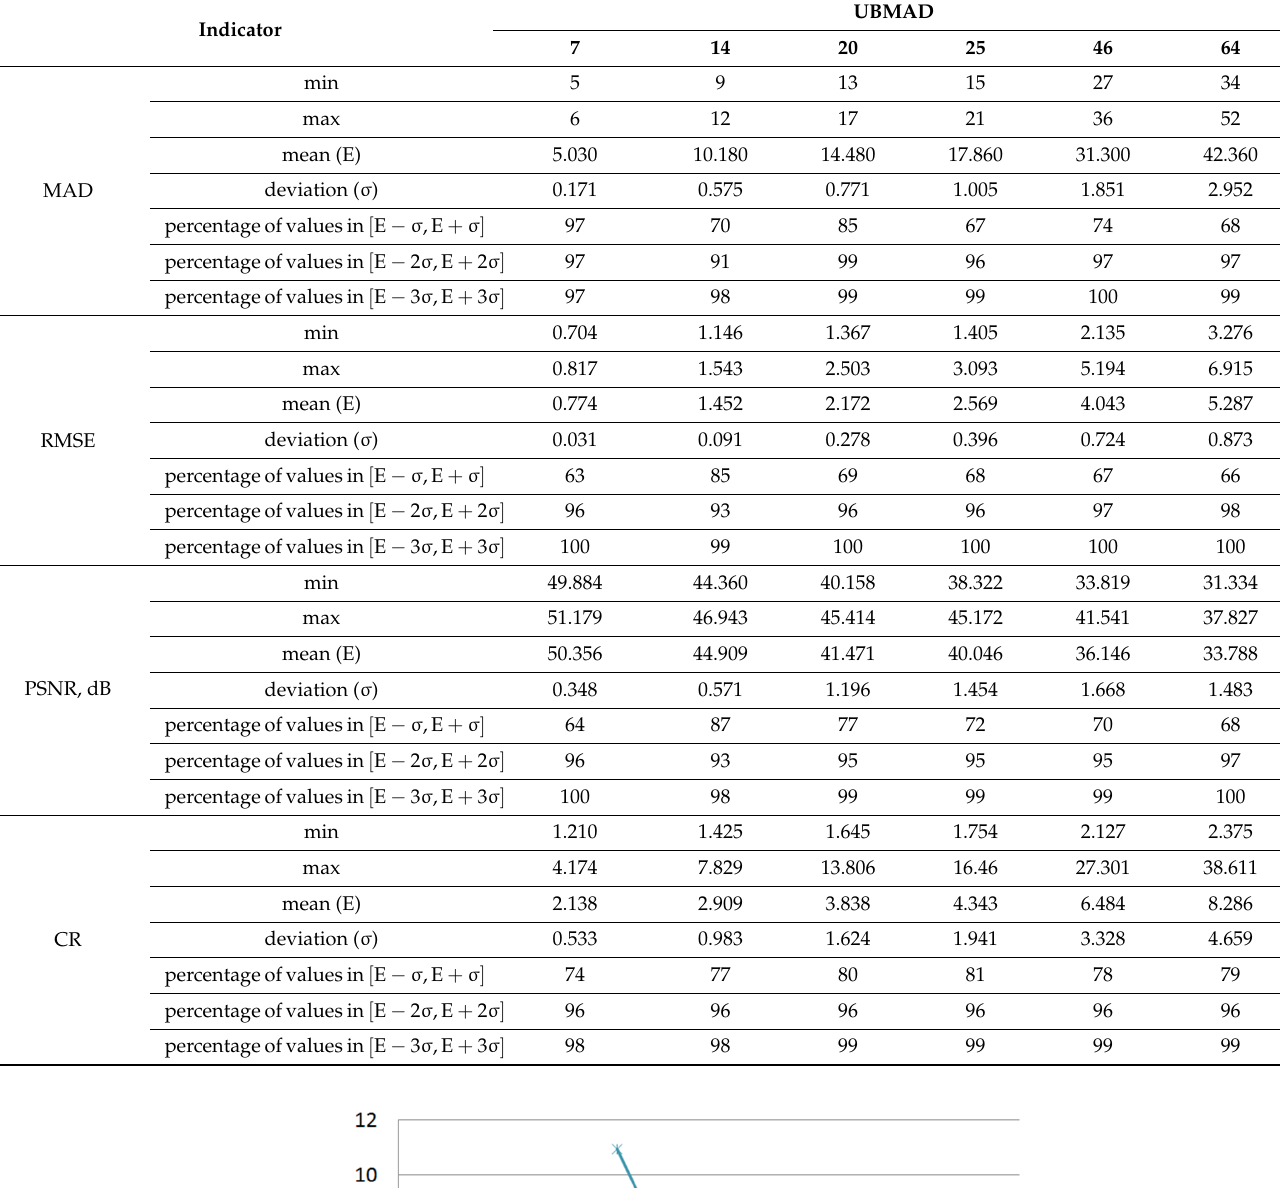
Table 3. DAT2 of the depth 2: indicators of compression efficiency.